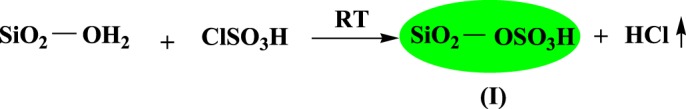
Preparation of silica sulfuric acid.